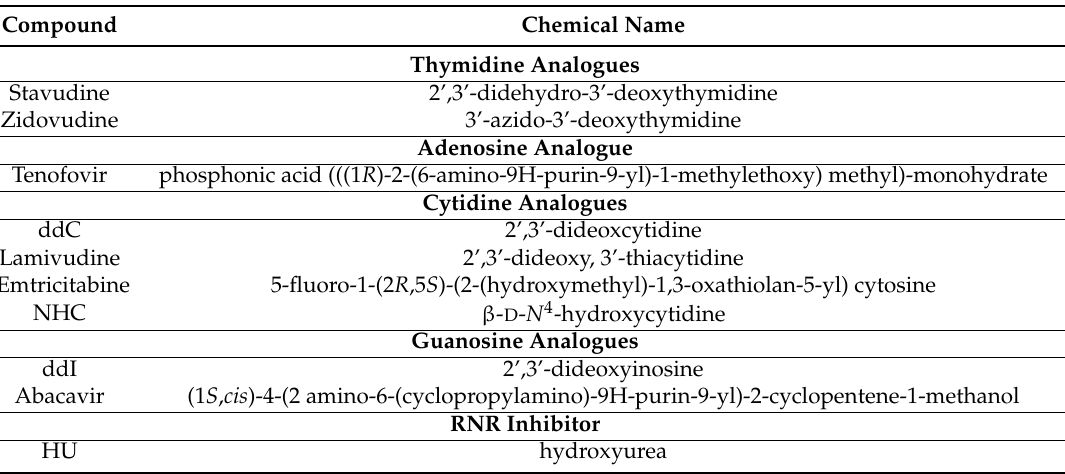
Table 1. List of compounds used